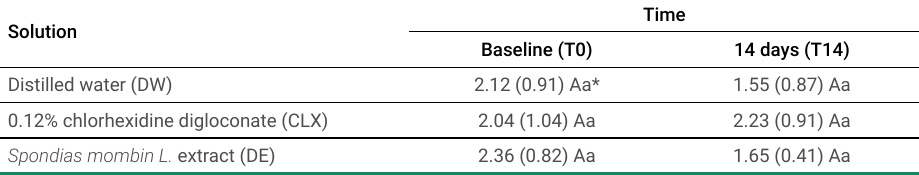
Table 2. Mean (standard deviation) of surface roughness (μm) according to the solution and time tested. Solution